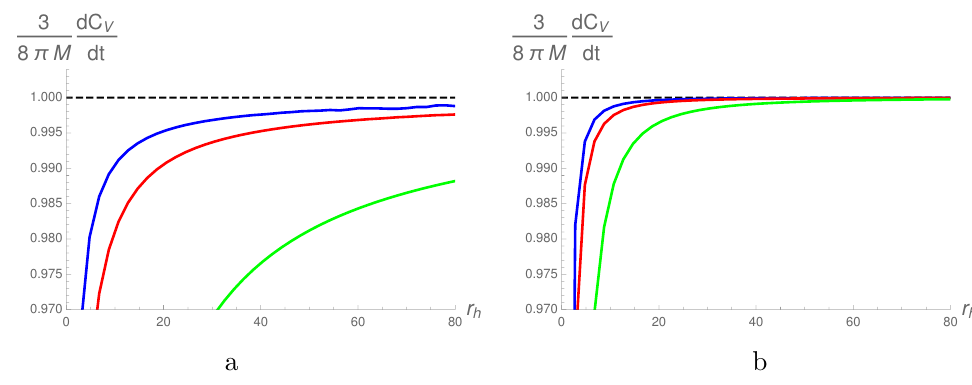
Figure 7 . Panel (a) shows the variation of dC V vs r h for d = 4 and n = 1 in the late time limit dt and (b) shows the same variation for d = 4 and n = 2. In both cases, the dotted line represents dC V the ratio 3 . The blue curves indicate a = 0 : 05, the red curves a = 0 : 1 and the green curves 8 (cid:25)M dt a = 0 :